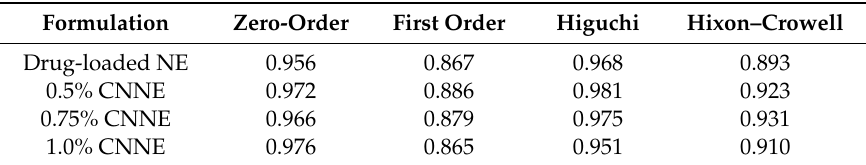
Table 7. Representation of pH and viscosity of the NE